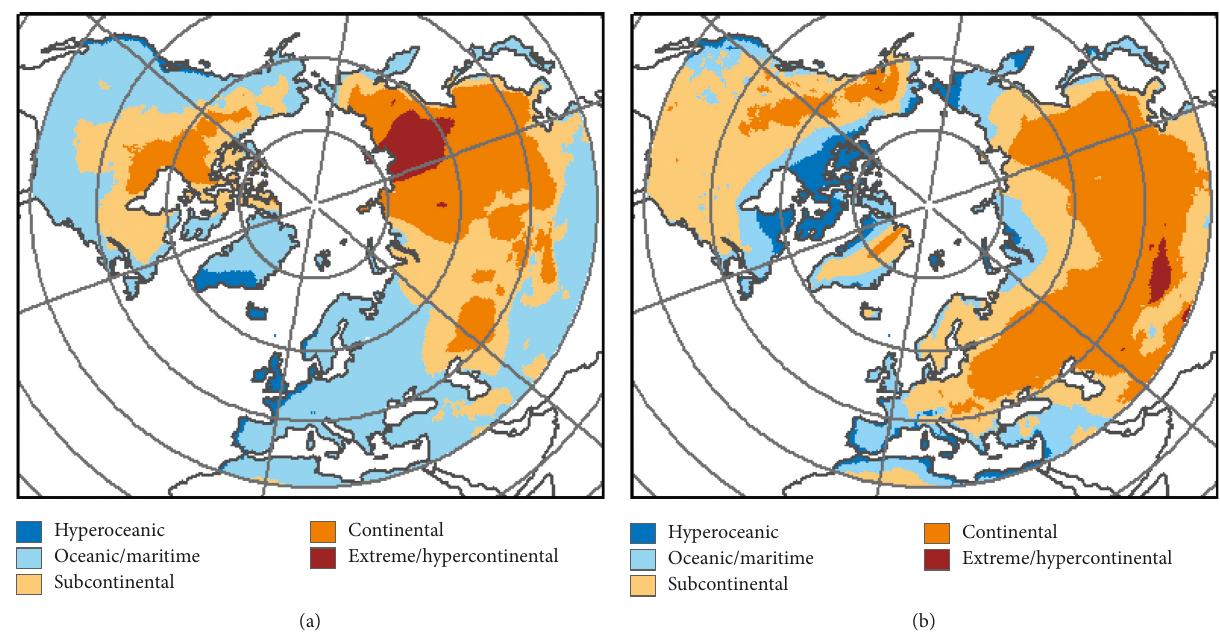
Figure 1: The climatological standard normal (1981–2010) of (a) Conrad’s Continentality Index (CCI) and (b) Kerner’s Oceanity Index (KOI).